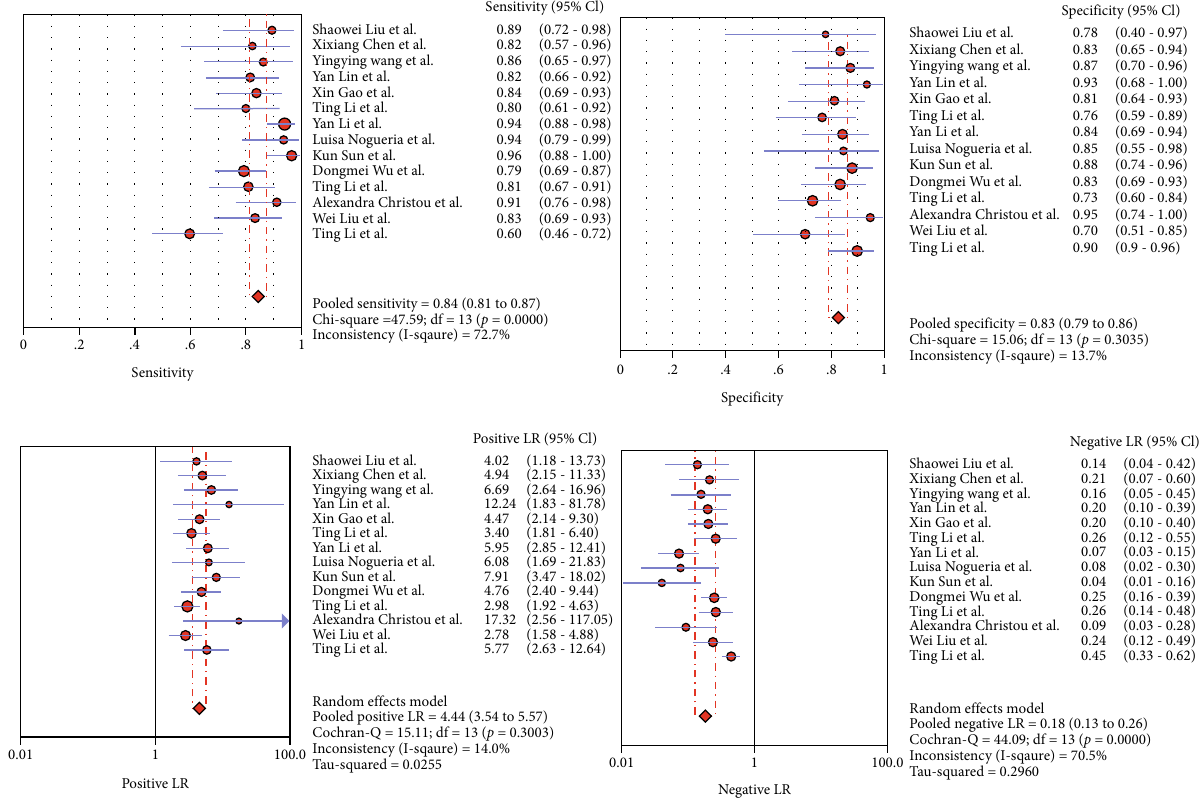
Figure 3: Forest plots of pooled sensitivity, pooled speci fi city, positive LR, and negative LR for MD in detecting benign and malignant breast lesions. LR: likelihood ratio; MD: mean di ff